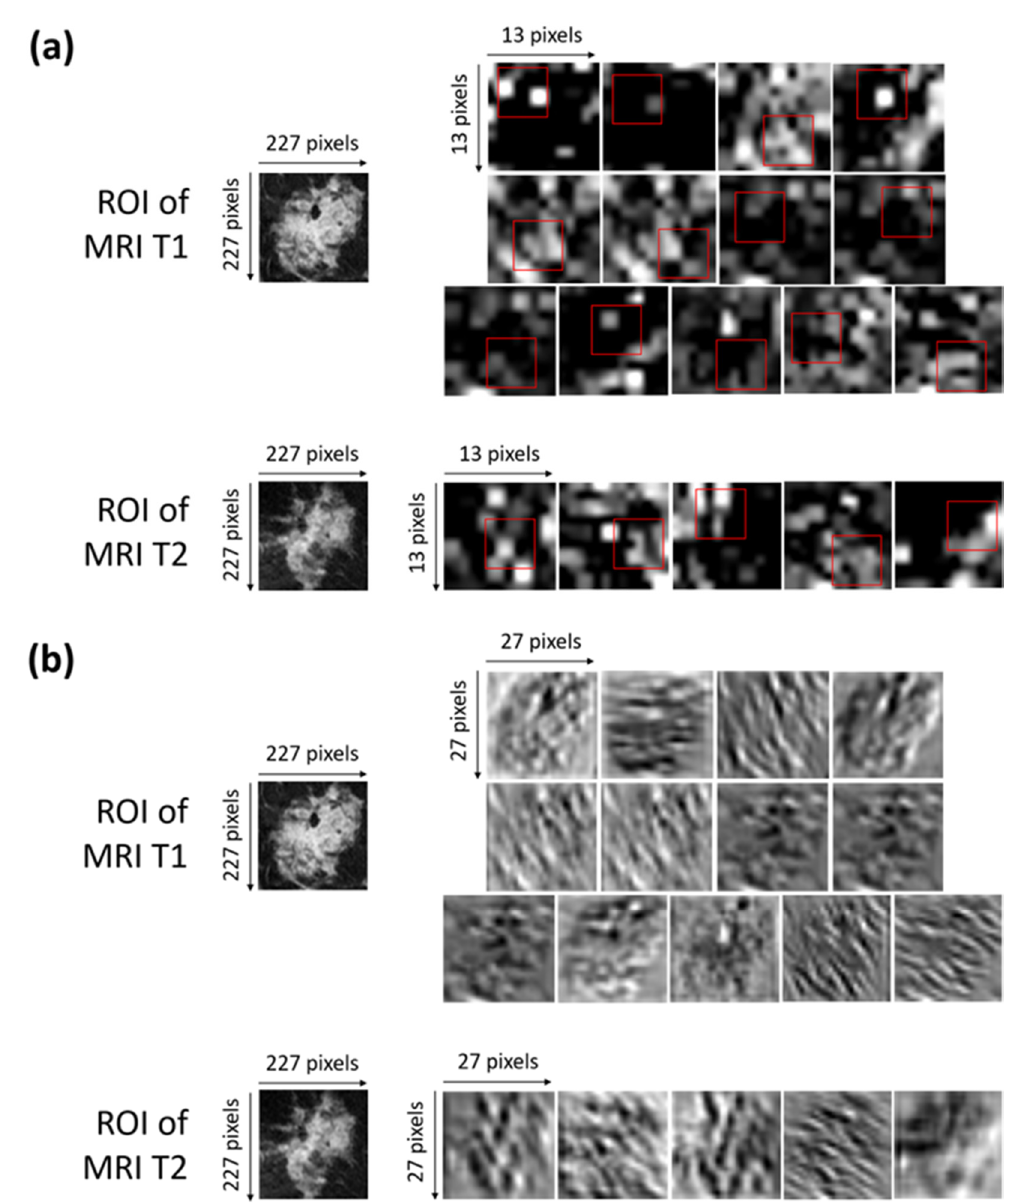
Figure 5. ( a ) Activation maps of the ROIs of both of the MRI T1 and MRI T2 exams from which the selected optimal features were extracted. The red squares outline, with more precision, the areas belonging to such features. Each ROI has dimensions of 227 × 227 pixels. Each activation map has original dimensions of 13 × 13 pixels and has been resized to the dimensions of the ROIs for a better visualization. ( b ) Convolutional maps related to the activation maps of the ROIs of both the MRI T1 and MRI T2 exams from which the selected optimal features were extracted. Each ROIs has dimensions of 227 × 227 pixels. Each convolutional map has original dimensions of 27 × 27 pixels and has been resized to the dimensions of the ROIs for better visualization.